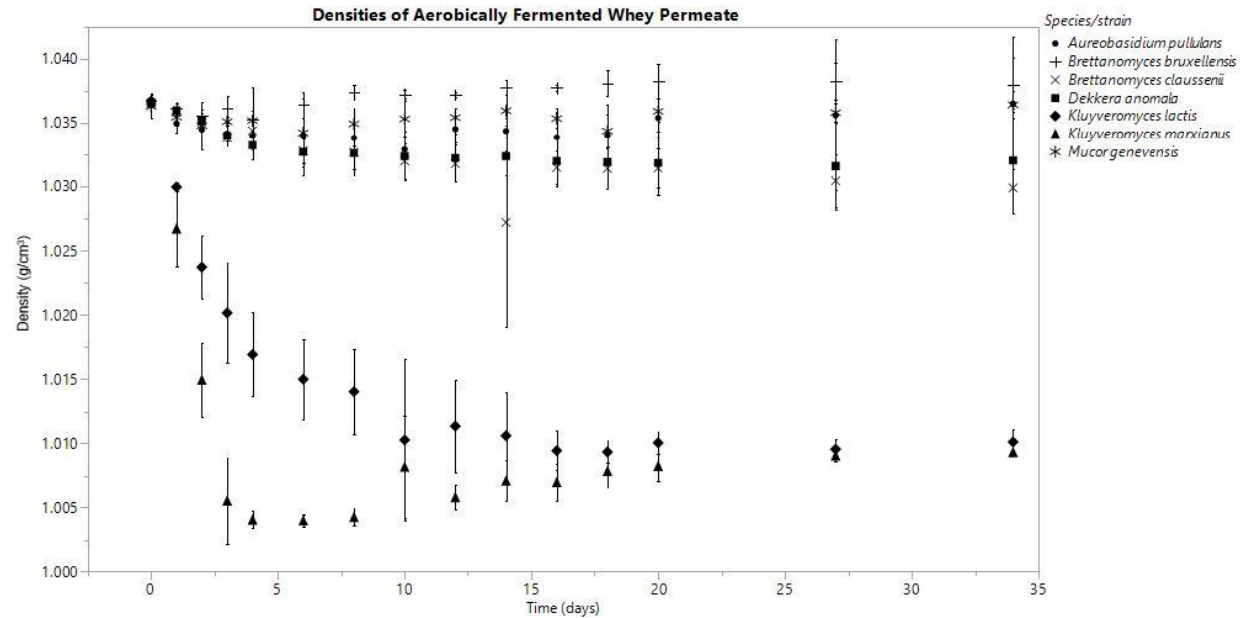
Figure 2. Means are represented by data points and standard deviation by error bars, which were calculated from three replicates for each species.